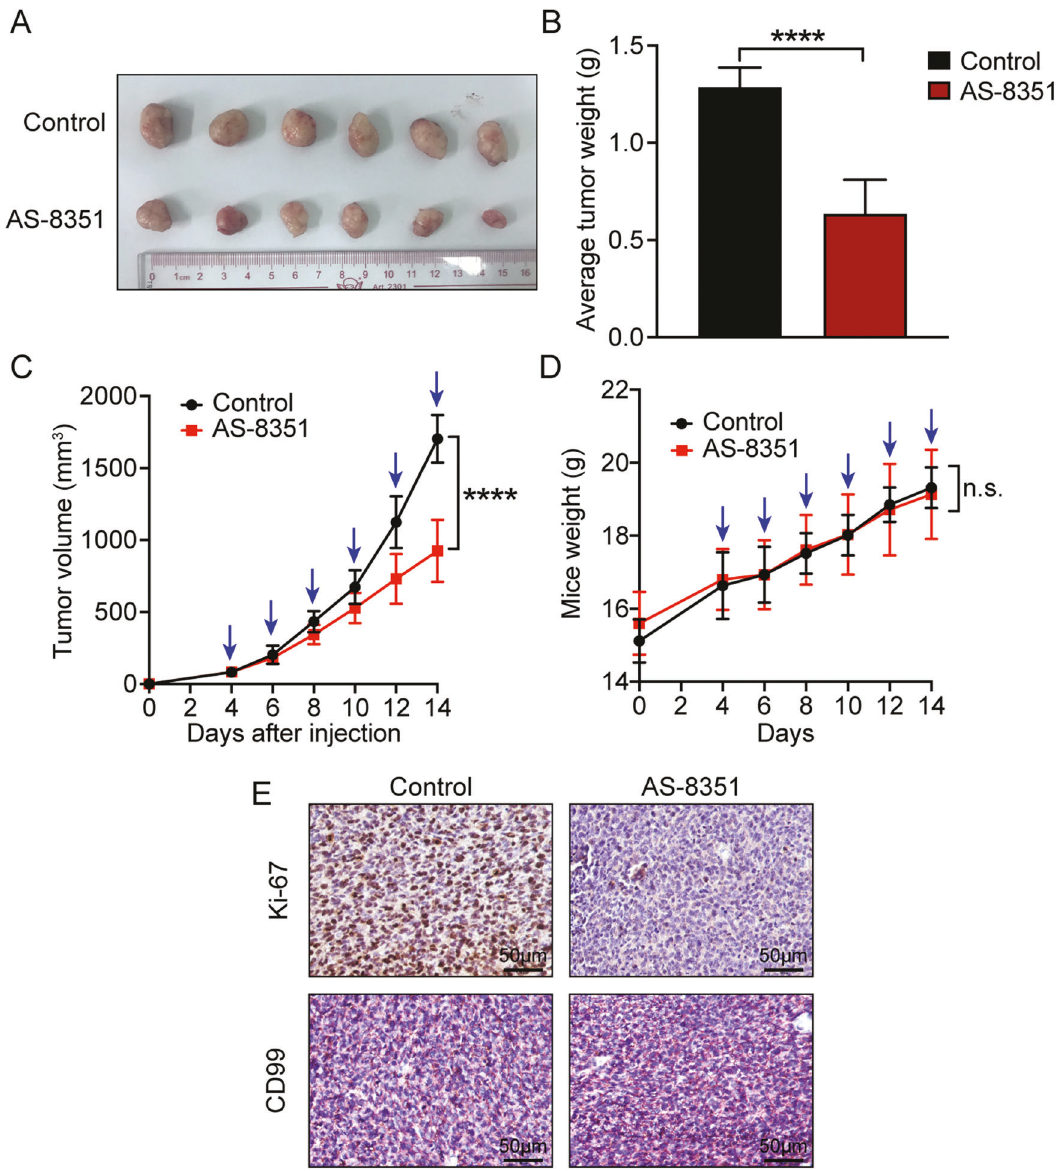
Fig. 6 KDM5B inhibitor AS-8351 attenuates tumor growth of Ewing sarcoma cells in vivo. A Xenograft tumors extracted from mice models. B Box plot of xenograft tumor weight between the control and AS-8351 treatment groups. C Tumor growth curves of the xenograft tumors. Blue arrows indicate that AS-8351 is being used. D Mice weight curves during the experiment. Blue arrows indicate that AS-8351 is being used. E Representative immunohistochemistry images of Ki-67 and CD99 protein expression in xenografts at the end of the experiment. Ki-67 is used to assess cell proliferation. CD99, typically expressed on the cell membrane of Ewing sarcoma, is used to identify cancer cells from the stroma. Scale bars: 50 μ m. Error bars in B , C , D indicate standard deviation. P values in B are determined by two ‐ tailed unpaired Student ’ s t test. P values in C and D are determined by two ‐ way ANOVA test. *Above the bars indicates signi fi cant difference; **** P < 0.0001; n.s. represents no signi fi cance. KDM5B was highly expressed in EwS and associated with poor [21, 38, 39]. A study showed that newborn mice developed from outcomes of patients. Knockdown of KDM5B signi fi cantly sup- KDM5B knockout embryos were lethal, mainly due to develop- pressed the cell proliferation of EwS. These suggested that KDM5B mental defects in the respiratory system and nervous system [40]. acted as an oncogene in EwS, which was similar to a previous KDM5B is involved in a range of human physiological processes as research [42]. well, including genome stability and stem cell differentiation [19]. The physiological cell cycle relies on the orderly activation and However, aberrant KDM5B expression can lead to tumorigenesis. degradation of cyclins and cyclin-dependent kinases in each Genome sequencing of human tumors unveiled a common phase. Among them, cyclins play a major role in regulating cycle mutation, ampli fi cation and overexpression of KDM5B in many phase transitions. Abnormal expression of cyclins could lead the cancer types [41]. In cancer cells, KDM5B regulates the expression cell cycle out of control, causing a series of terrible events such as of oncogenes and tumor suppressors by modulating H3K4 chromosomal instability and abnormal mitosis, which ultimately methylation levels, but the functions and mechanisms of KDM5B results in the occurrence of tumors [43]. CCNE1, a member of are not clear in EwS. In the present study, we discovered that